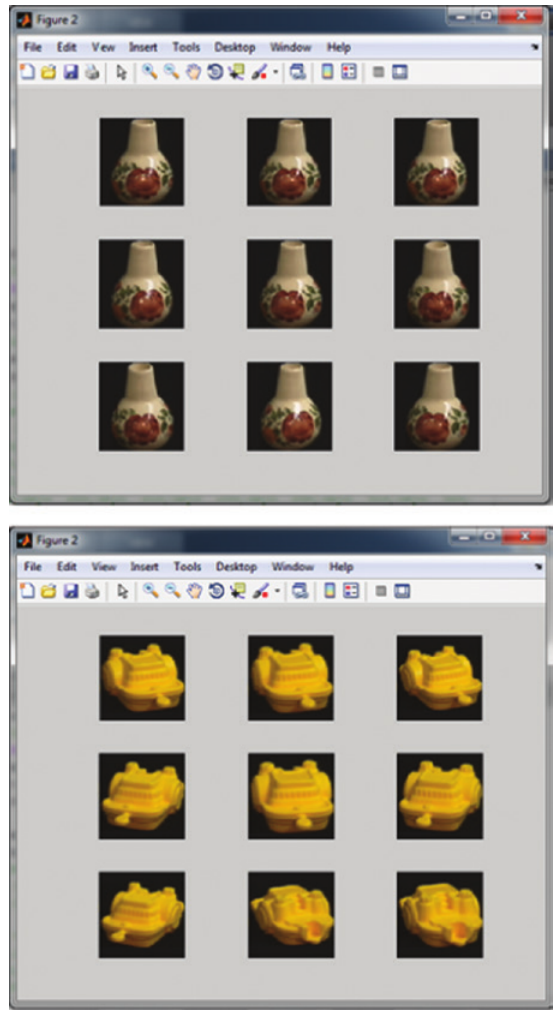
Figure 10: Relevant Objects Retrieved for Categories 1 and 4 Images with Additive Gaussian Noise and Salt and Pepper Noise, Respectively.